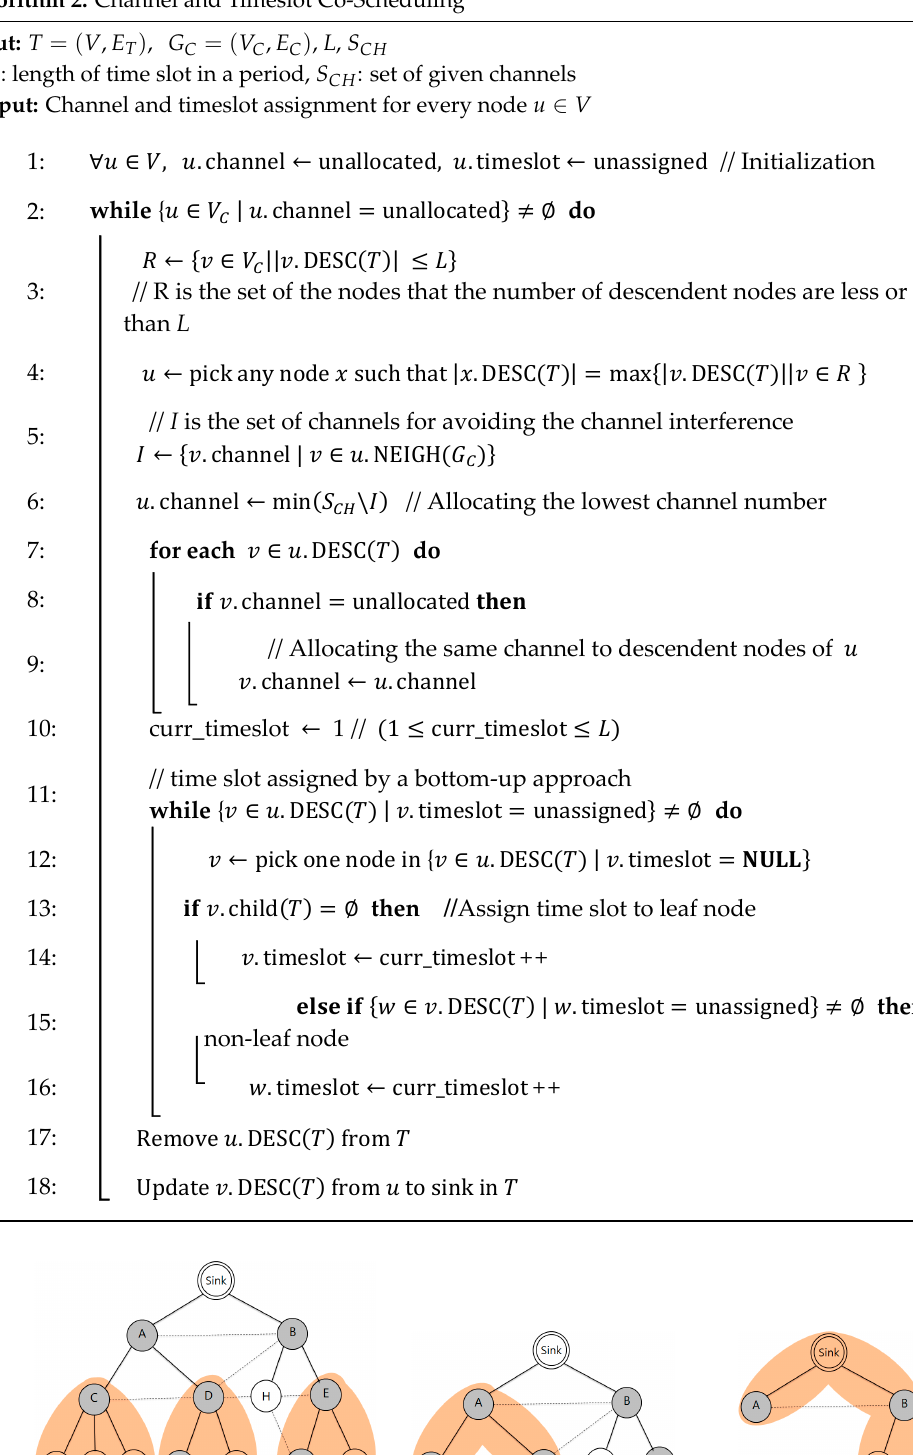
Algorithm 2. Channel and Timeslot Co-Scheduling